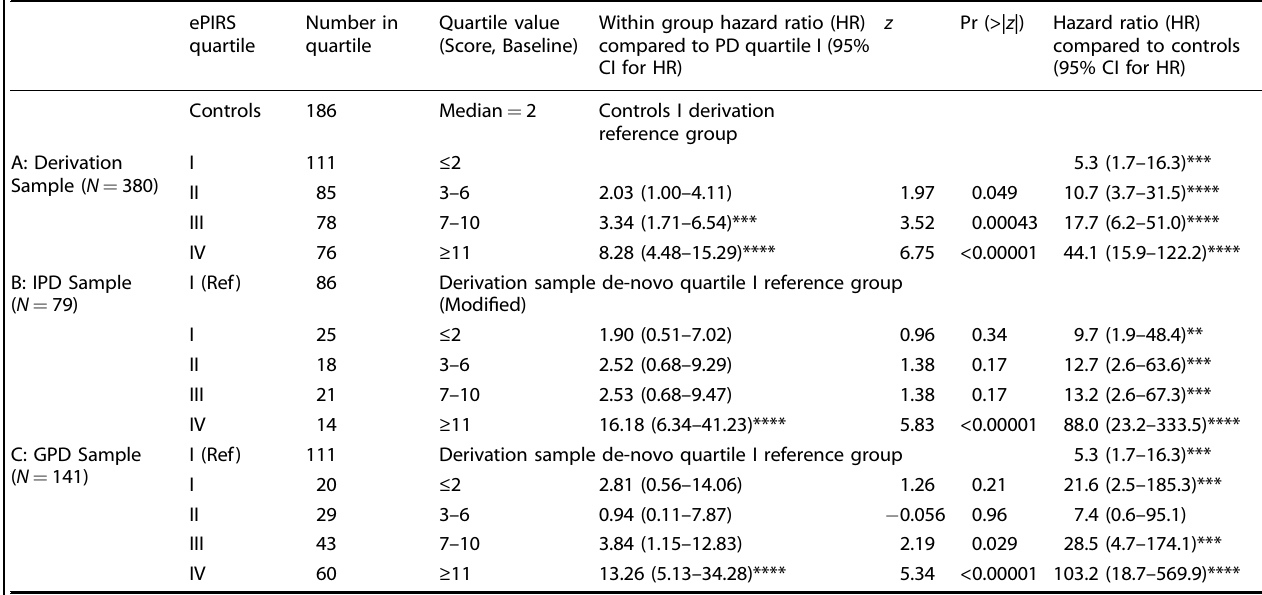
Table 3. Baseline ePIRS quartile ranking predicts likelihood of advancing HY